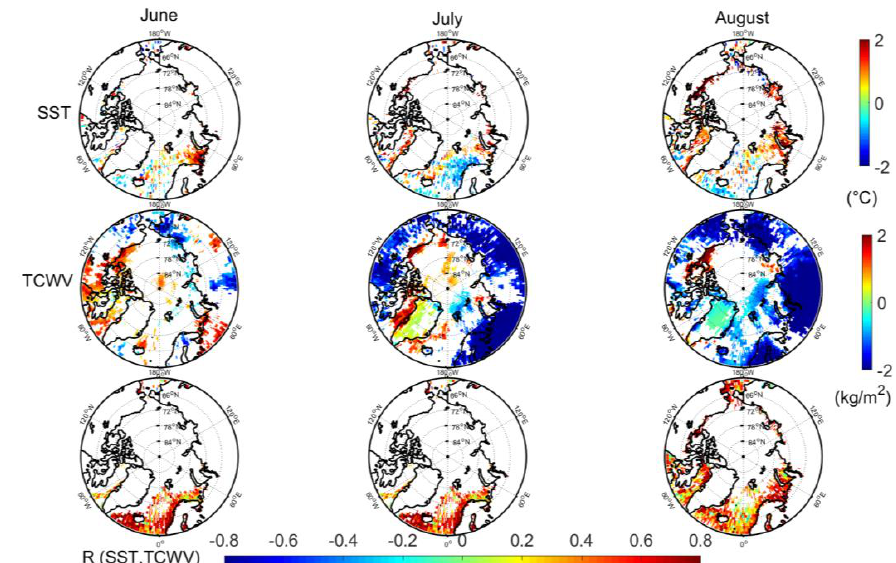
Figure 6. Upper plots: Absolute trends of SST in June, July, and August from left to right, respectively, by °C/decade of (2001–2015). Middle plots: Absolute trends of TCWV in June, July, and August from left to right, respectively, by kg/m 2 /decade of (2001–2015). Lower plots: Correlation coefficients of TCWV with SST in June ( left ), July ( middle ), and August ( right ) for the whole 15 years of data. Trend colour bars are on the right. Correlation maps use the colour bar on the bottom. Only statistically significant trends at the 95% confidence level based on a Student’s t test are shown. Pixels with missing data or not significant trends at the 95% confidence level are in white Atmosphere 2017 , 8 , 241